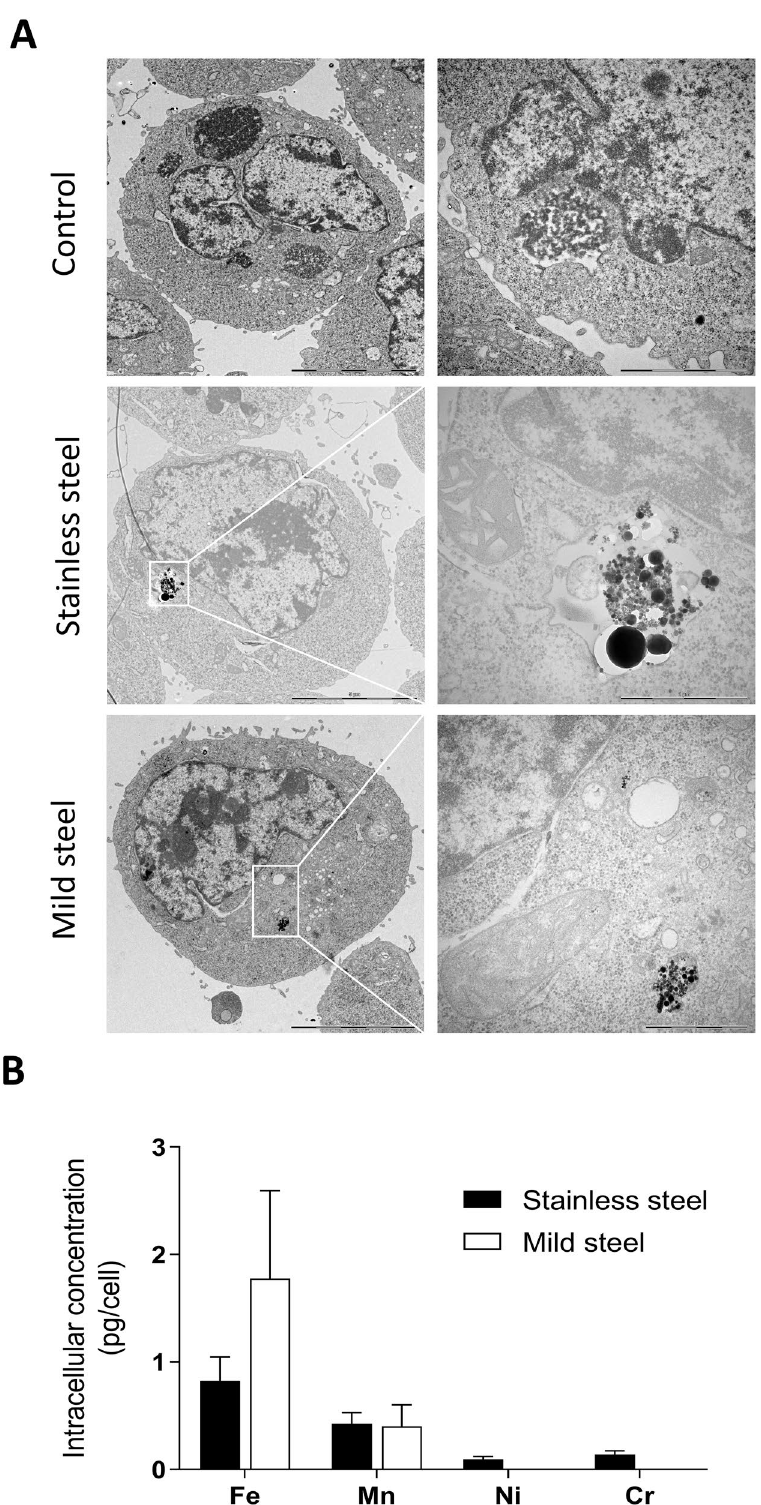
Figure 4. Intracellular localization and metal content of mouse embryonic stem cells exposed to welding particles. The cells were exposed to 50 µg/mL of stainless steel or mild steel particles for 24 h. ( A ) Cellular localization of the particles was confirmed by TEM. ( B ) The intracellular concentrations of Fe, Mn, Ni and Cr were quantified by ICP-MS and the results expressed as pg of metal per cell. Figure 4B was created using GraphPad Prism version